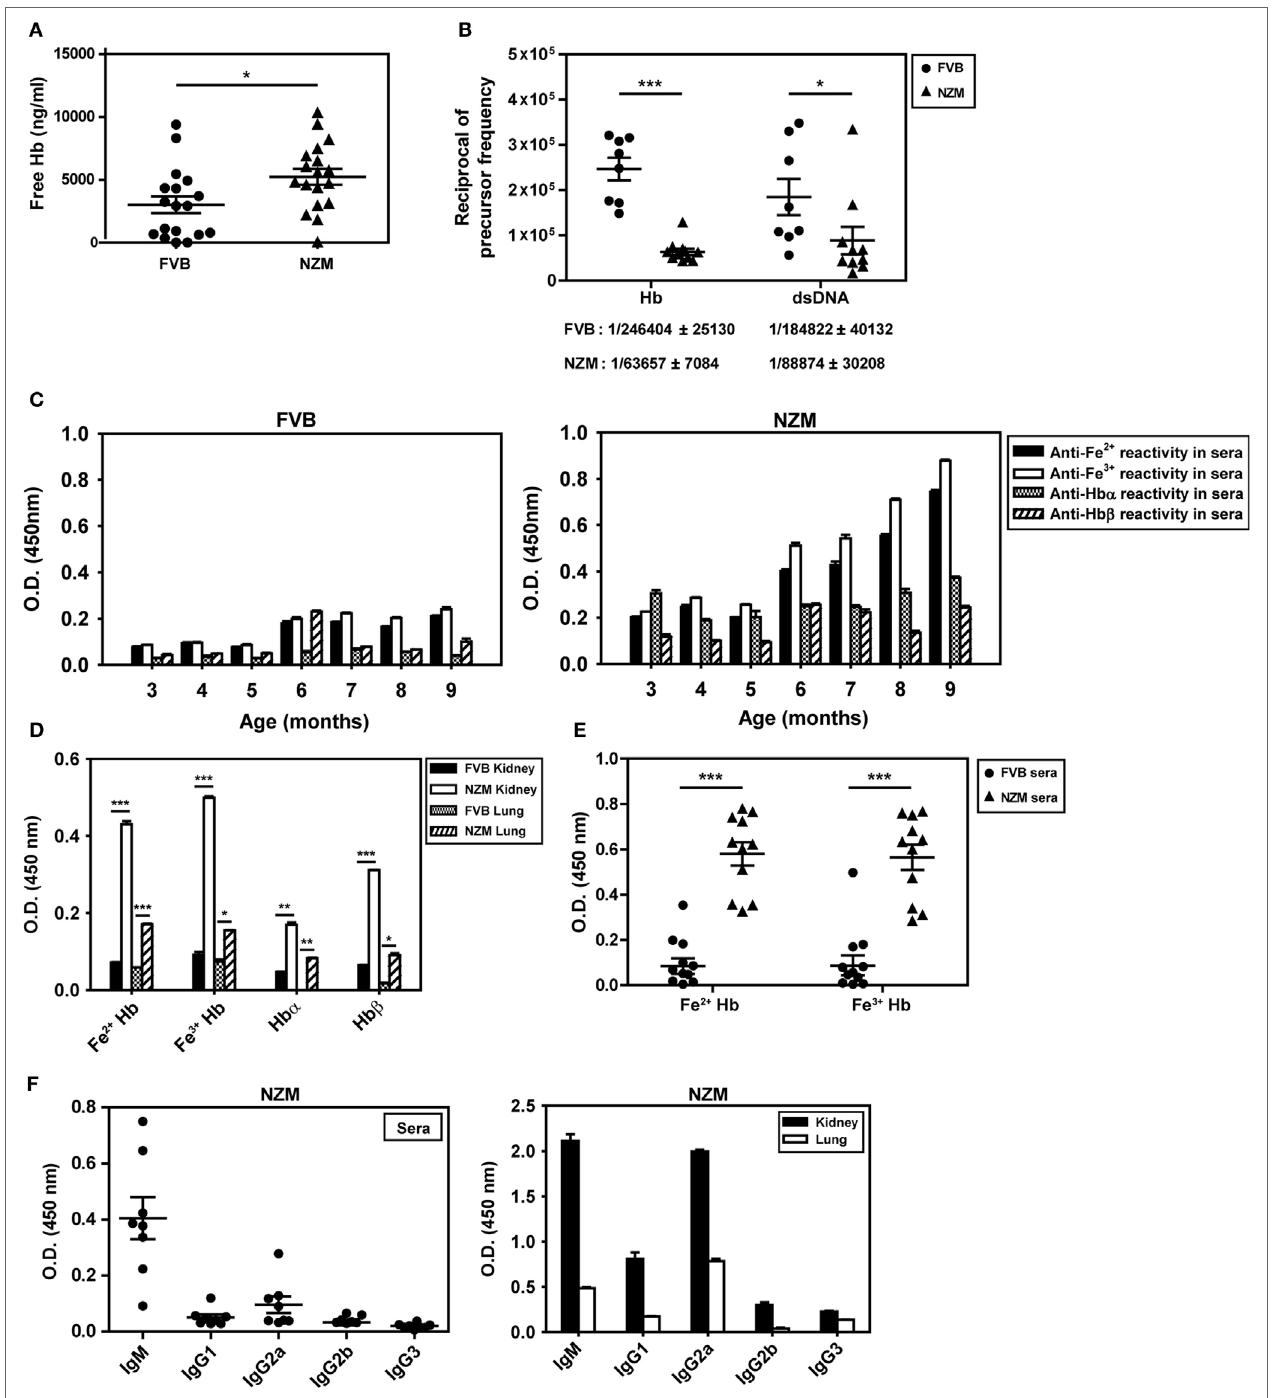
FigUre 2 | Plasma hemoglobin (Hb) levels, anti-Hb B cell precursor frequencies, and endogenous anti-Hb autoantibody responses in the sera and organ eluates of FVB and NZM mice. (a) Hb concentrations in the plasma of 4-month-old FVB and NZM mice ( n = 18). Symbols represent individual mice and mean ± SEM are also depicted. (B) Anti-Hb and anti-dsDNA B cell precursor frequencies in 4-month-old NZM ( n = 11) and FVB mice ( n = 8). Symbols represent individual mice and mean precursor frequencies ± SEM are also depicted. Numerical values (mean ± SEM) of anti-Hb and anti-dsDNA B cell precursor frequencies in the two strains are indicated below each graph. (c) Reactivity of antibodies in pooled sera ( n = 12) from FVB (left panel) and NZM (right panel) mice, drawn at different ages, to Hb (Fe 2 + or Fe 3 + ), Hb α , and Hb β . (D) Antibodies to Hb (Fe 2 + or Fe 3 + ), Hb α , and Hb β in kidney and lung eluates from NZM and FVB mice at 9 months. (e) Reactivity of antibodies in the sera of FVB and NZM mice (at 7 months) to Hb (Fe 2 + or Fe 3 + ). Symbols represent individual mice, and mean ± SEM are also depicted. (F) Isotype analysis of anti-Hb antibodies in sera at 7 months (left panel) and in organ eluates at 9 months (right panel) from NZM mice. Symbols in the left panel represent individual mice, and mean ± SEM are also depicted. In all bar graphs, data represent mean ± SEM (* p < 0.05, ** p < 0.005, *** p <